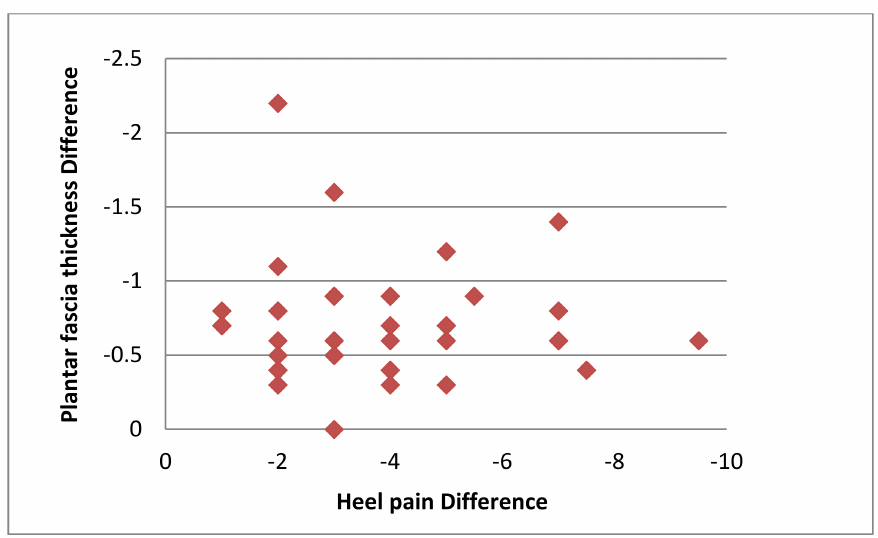
Figure 2. Scatter plot of the relationship between the reduction in heel pain and plantar fascia